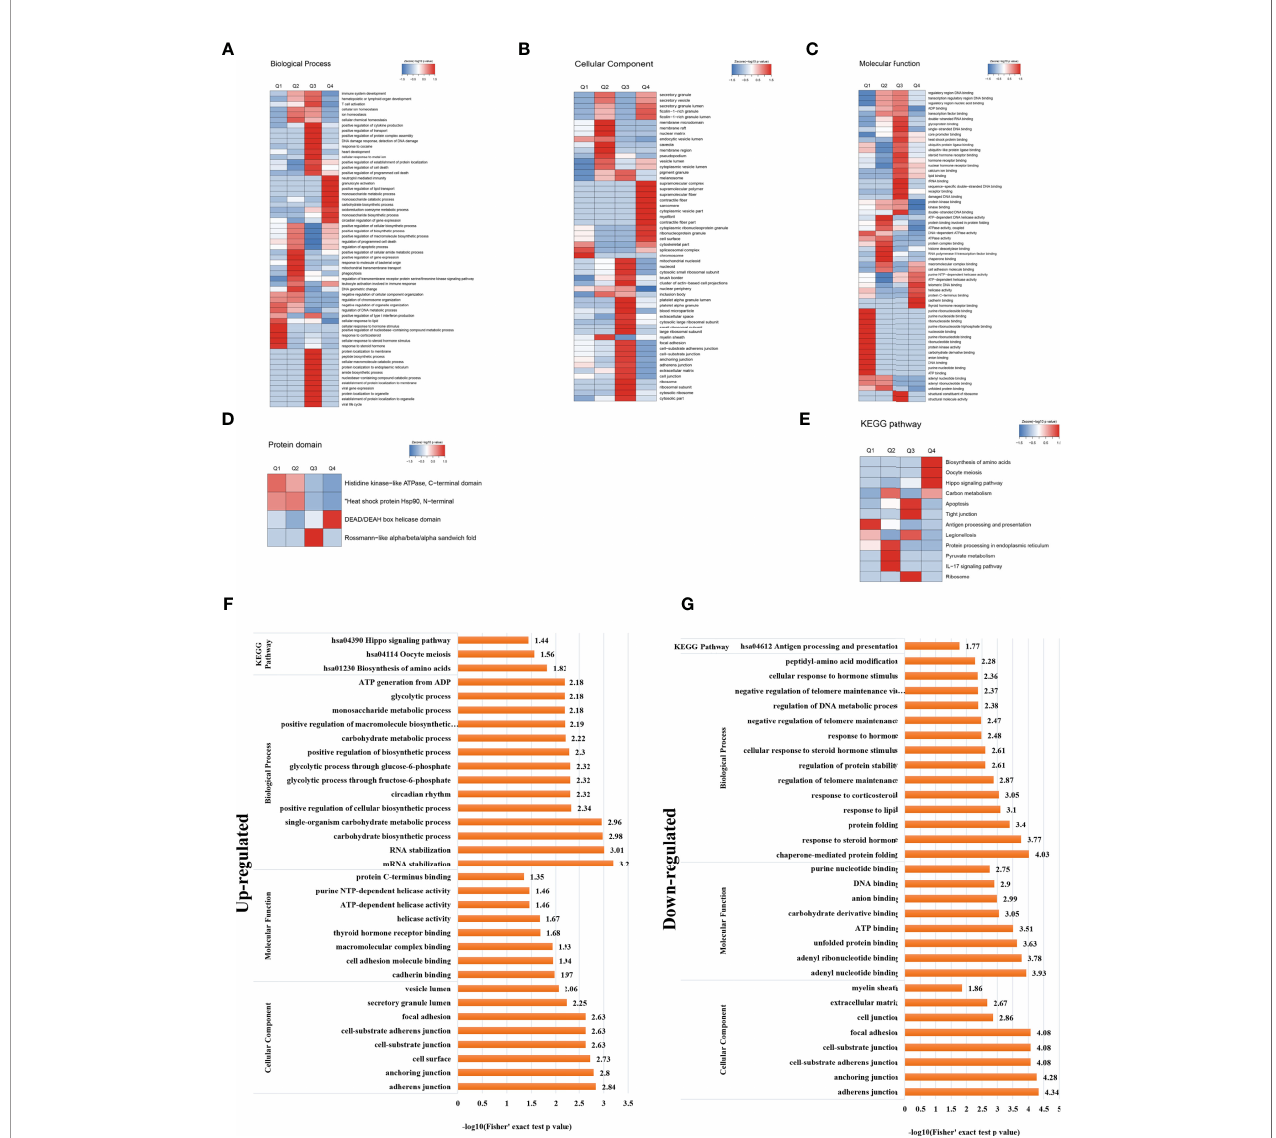
FIGURE 4 | Clustering analysis of identi fi ed proteins containing differentially expressed K Cr sites and functional characterization of crotonylated proteins. Modi fi ed sites were classi fi ed into four classes based on fold change. Heat maps showing the results of a cluster analysis of data from the (A – C) GO term, and (D) protein domain analyses, and (E) KEGG pathway. Functional characterization of crotonylated proteins containing (F) up- and (G) downregulated K Cr sites at 30 h post- transfection, showing biological processes, cellular components, molecular functions, and KEGG